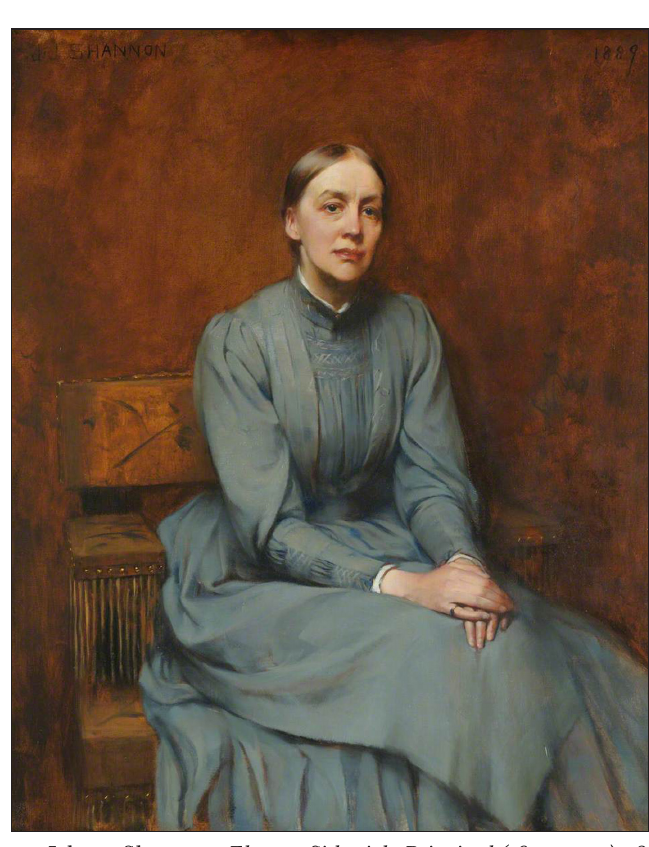
Fig. 3 : James Jebusa Shannon, Eleanor Sidgwick, Principal (1892–1910) , 1892, oil on canvas, 127 × 102 cm, Newnham College, University of Cambridge,